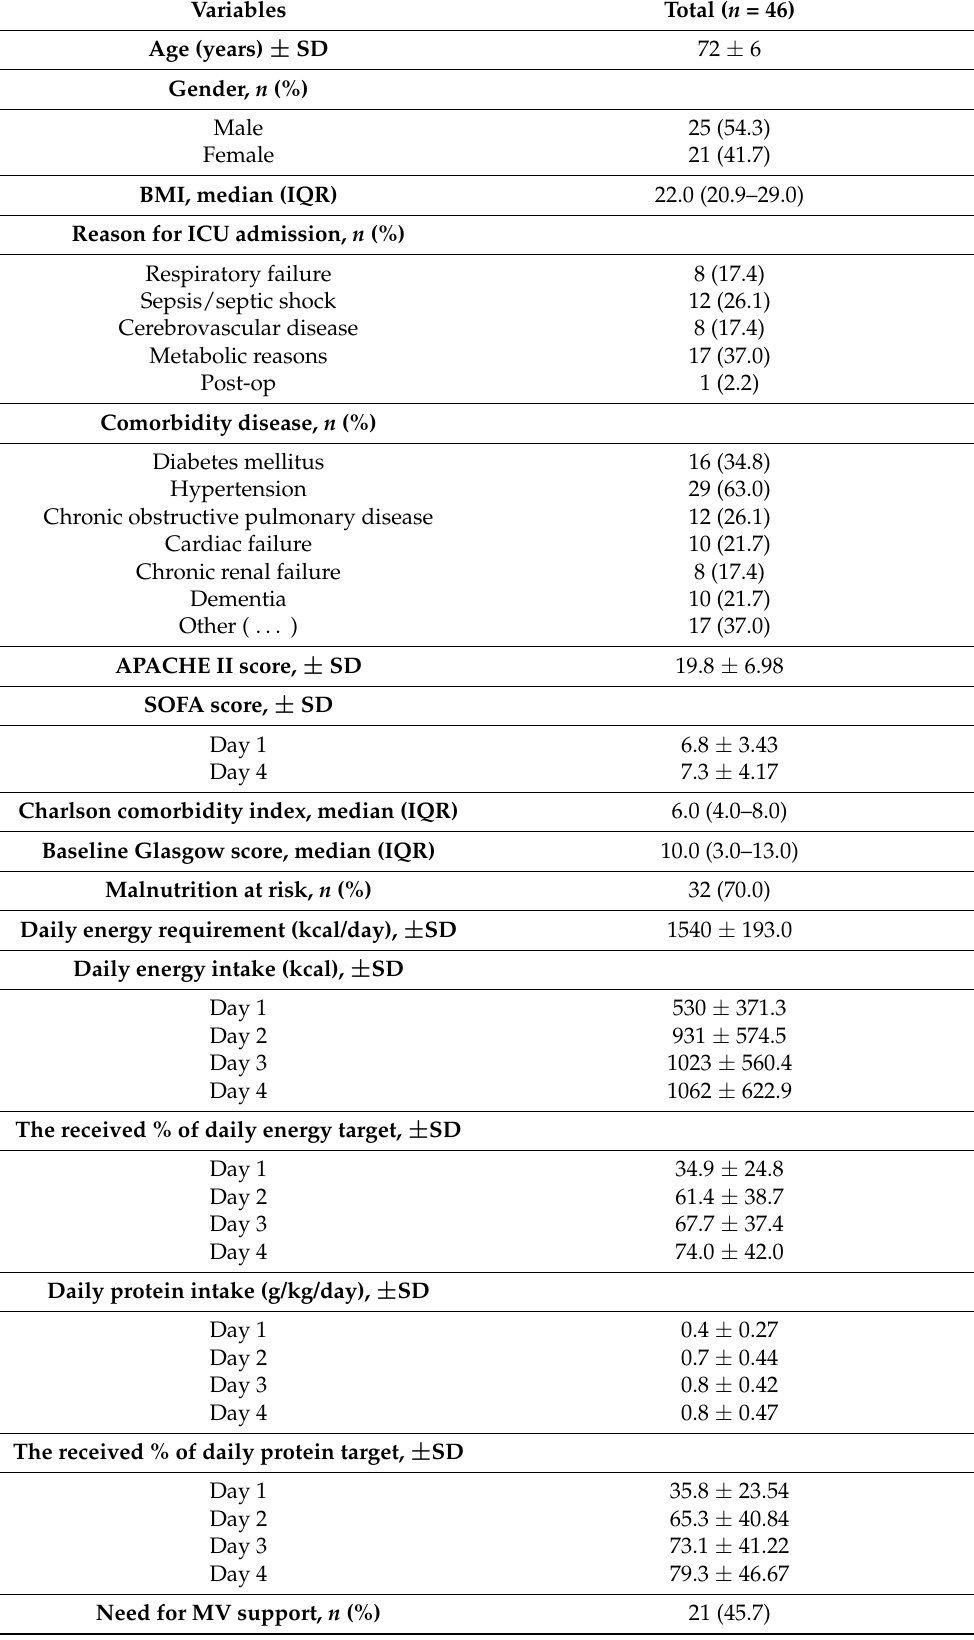
Table 1. Demographic and clinical characteristics of the study